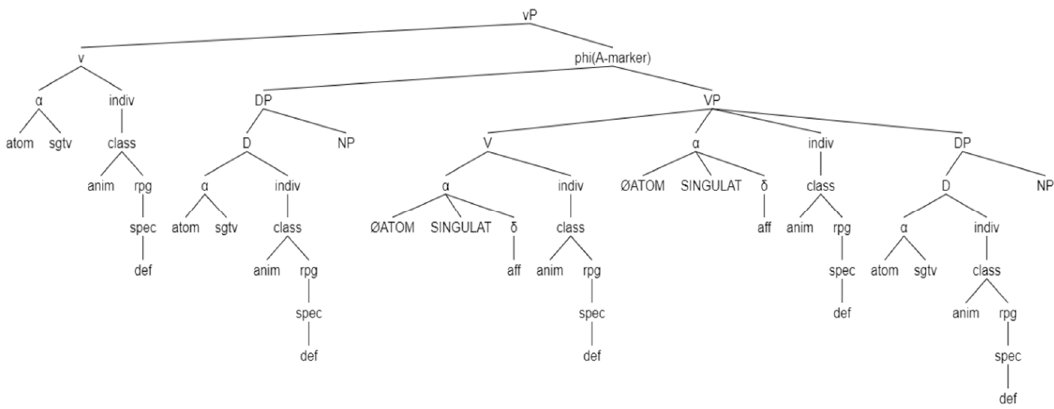
Figure 29. After insertion of v*, inheritance, Agree, and labeling. 36 .